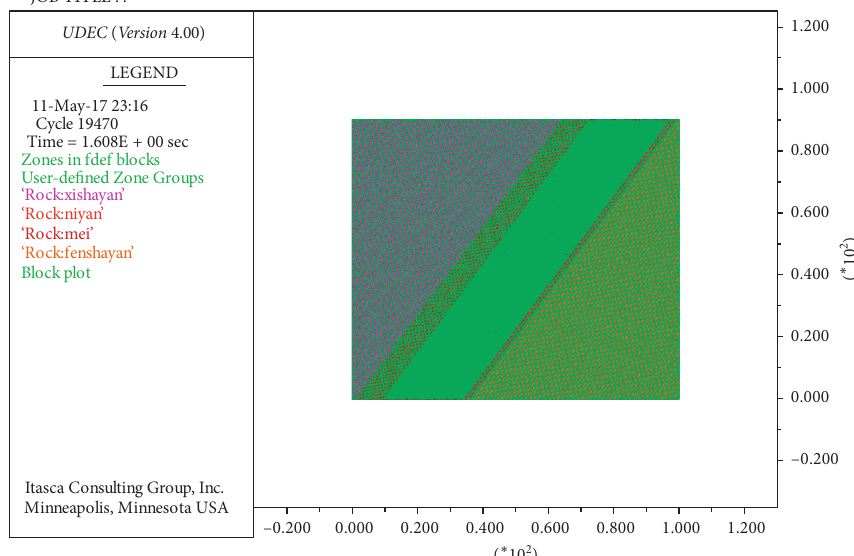
Figure 10: Numerical calculation model.